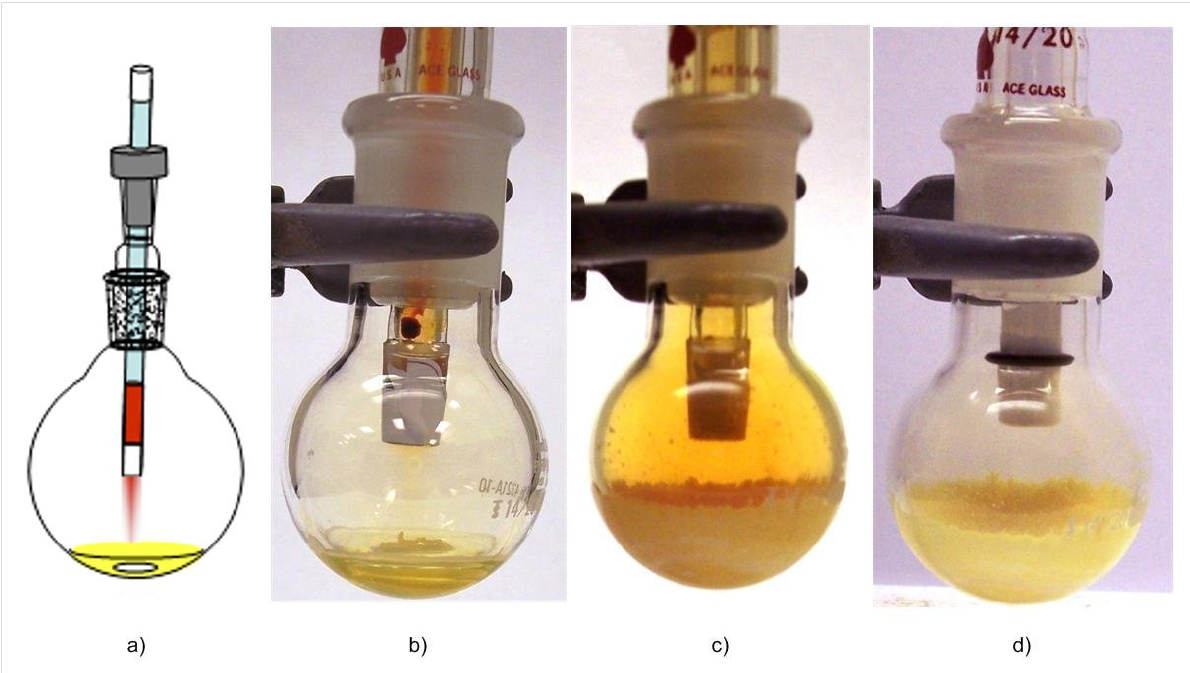
Figure 2: Bromination of cis -stilbene. a) scheme of the reaction apparatus, b) reaction mixture (note a thin stream of bromine vapors flowing straight down), c) bromination was completed when the color of bromine vapors persisted, d) after a work-up tube was inserted bromine vapors were